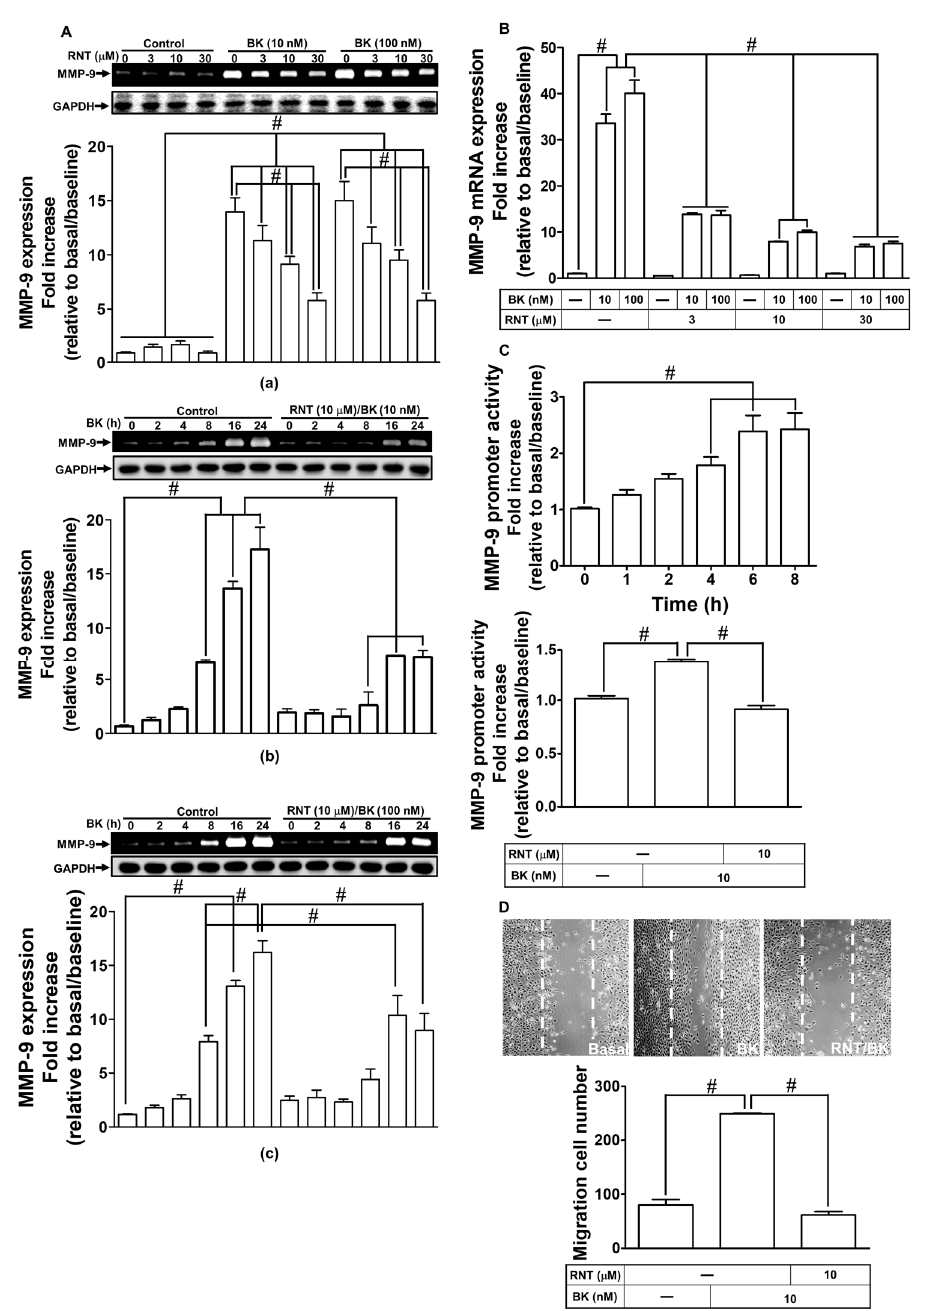
Figure 1. Rhamnetin (RNT) attenuates MMP-9 expression and cell migration induced by bradykinin (BK) in RBA-1 cells. ( A ) The cells were incubated with various concentrations of RNT (3, 10, 30 µ